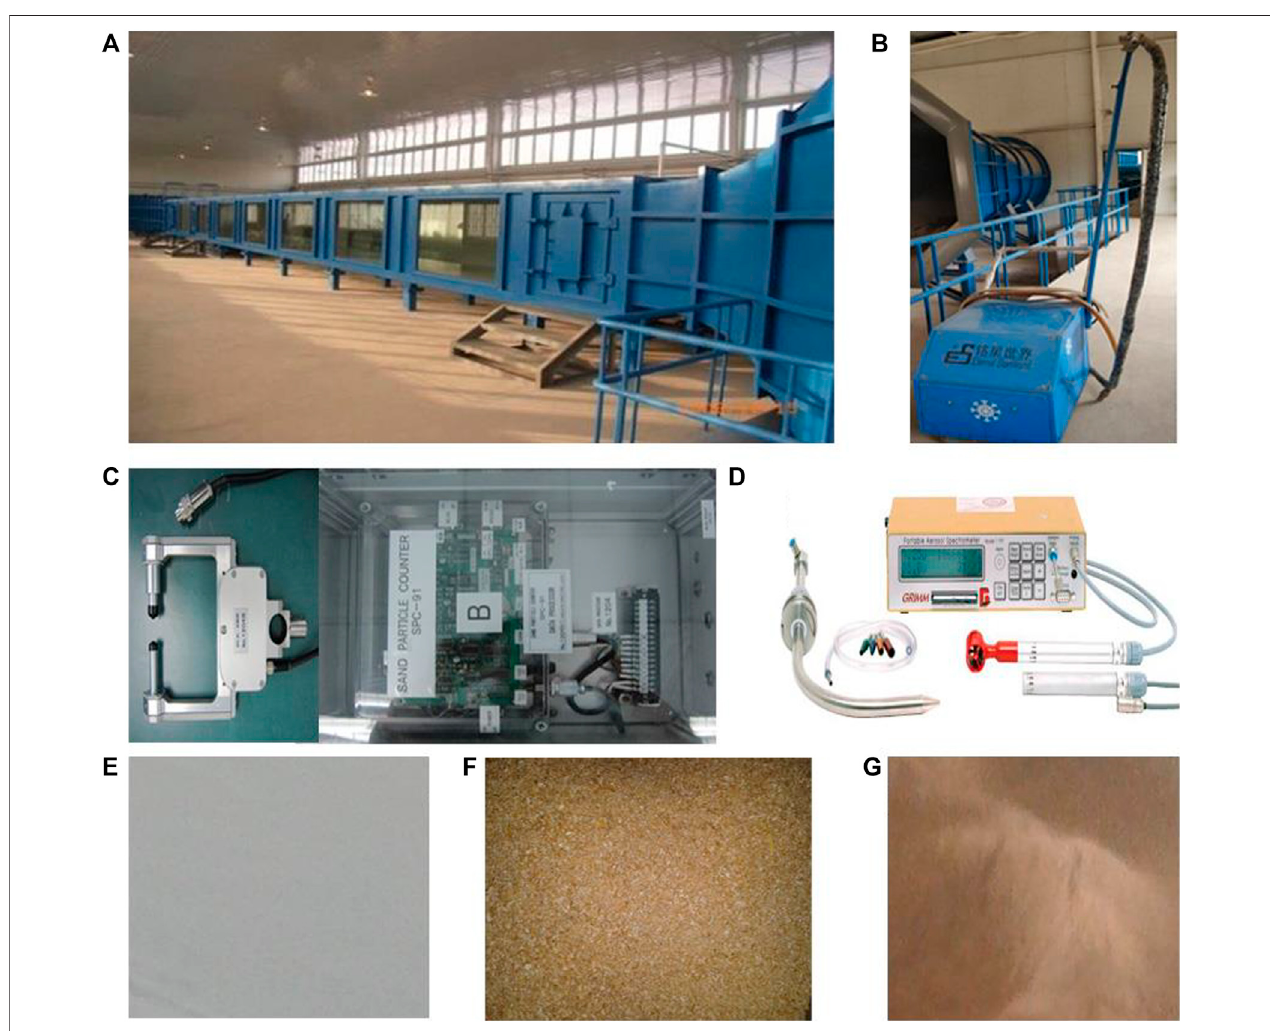
FIGURE 1 | Major devices and granular materials in this study, including (A) Multi-functional Environment Wind Tunnel at Lanzhou University, (B) the moveable snowmaker, (C) prober andprocesserofthesand particle counter(SPC-91), (D) aerosol spectrometer, (E) arti fi cialsnowparticles, (F) fi newheat branparticles, and (G) fi ne-sieve soil